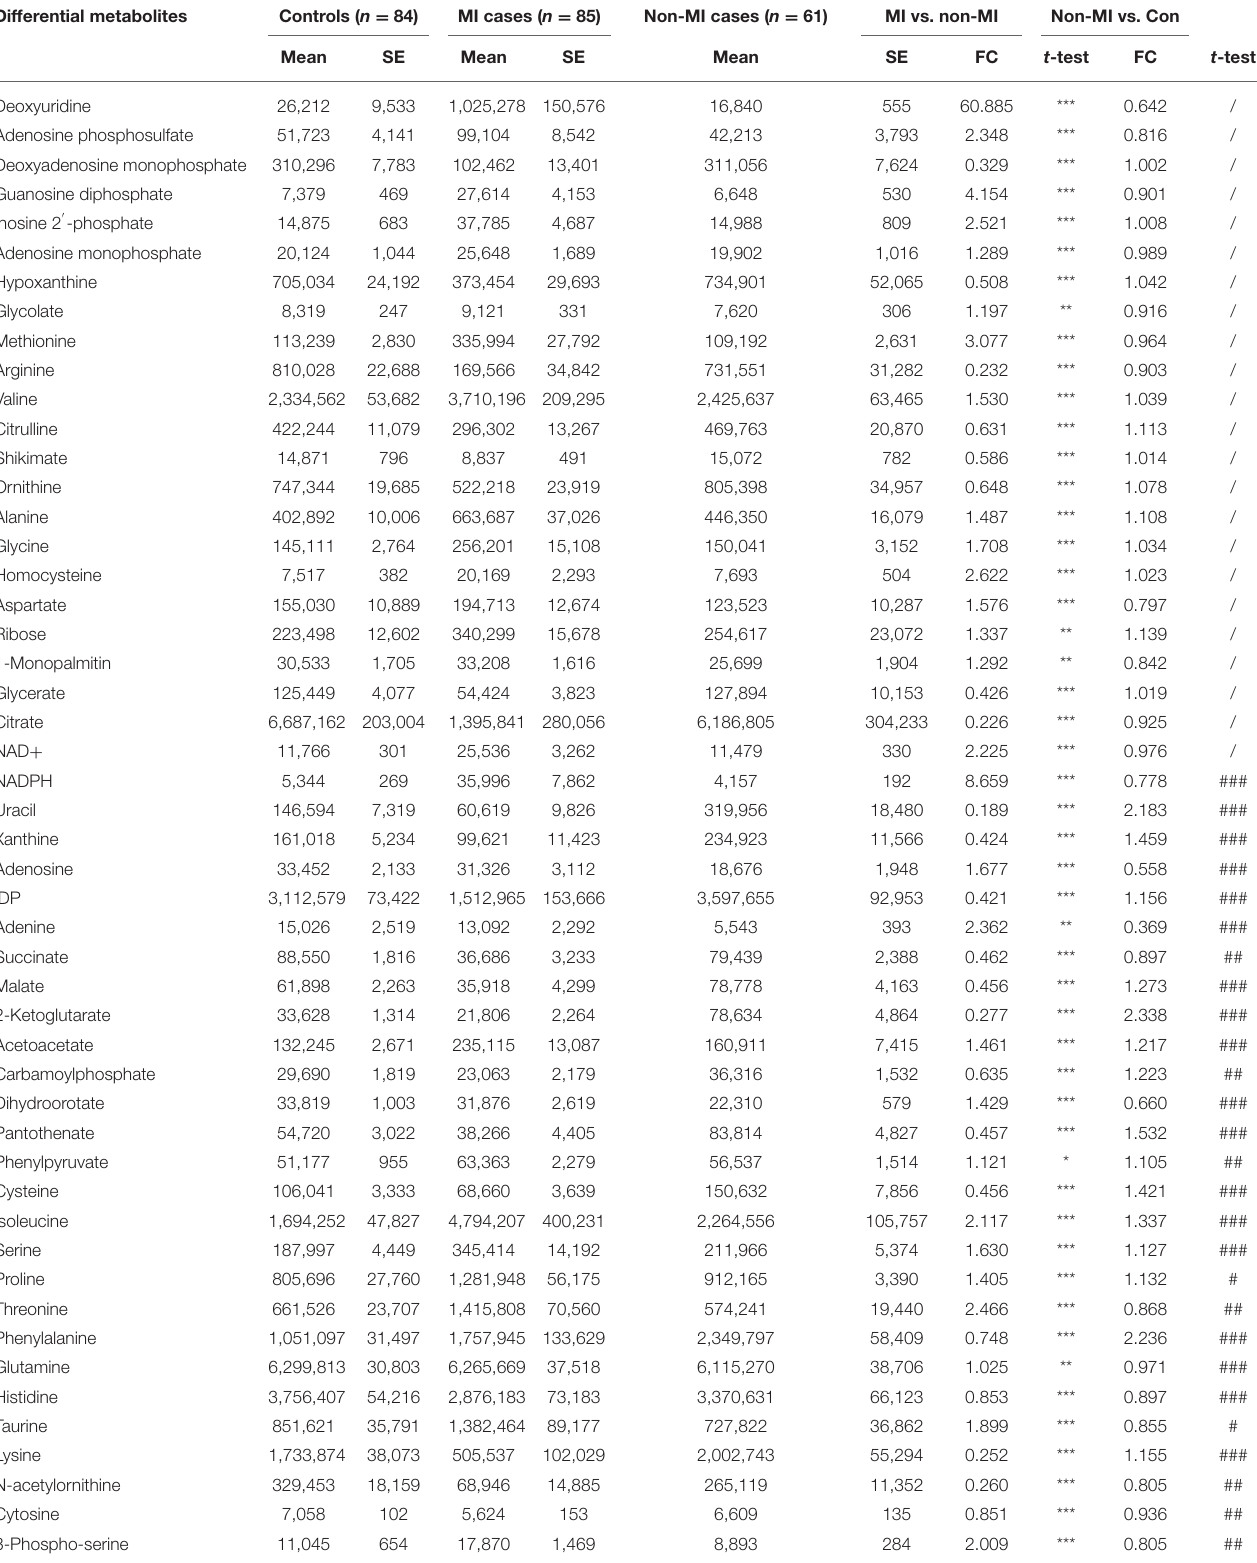
TABLE 3 | List of discriminant metabolites: non-MIs vs. controls and MIs vs. non-MIs. Differential metabolites Controls ( n =